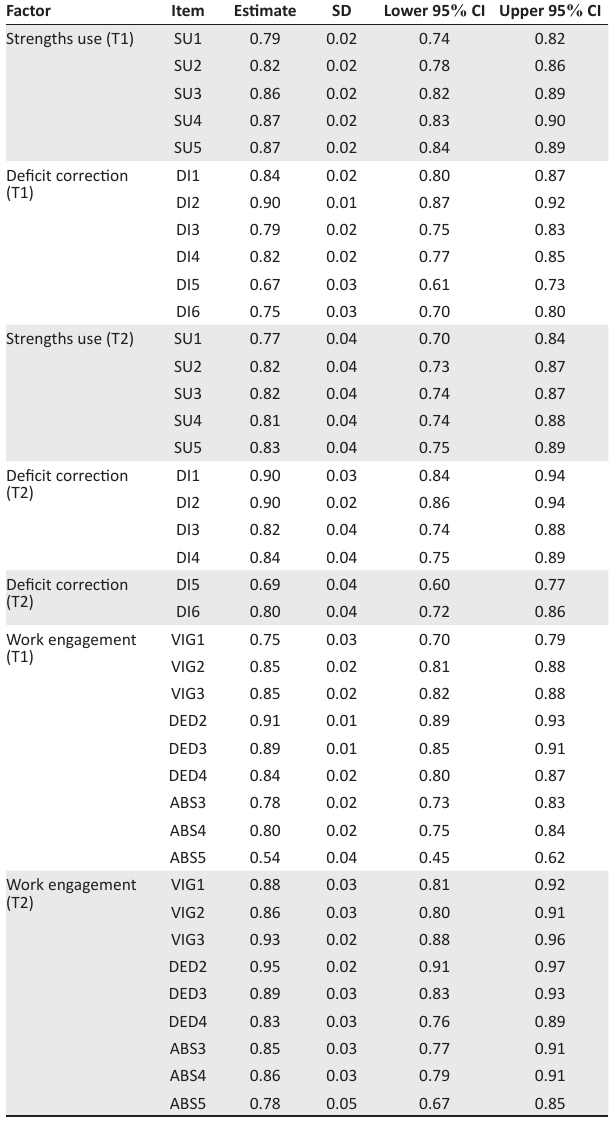
TABLE 4: Standardised loadings for the latent factors at time interval 2 (T2). Factor Item